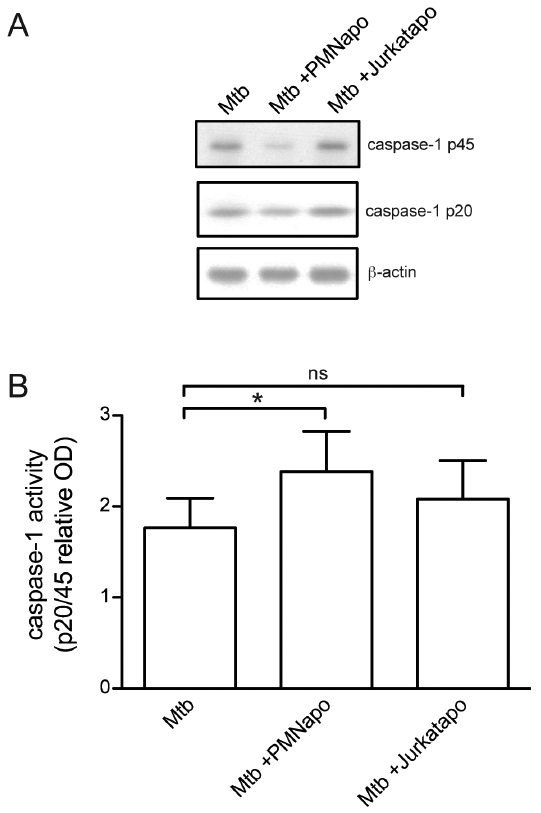
Figure 6. Apoptotic neutrophils augment caspase-1 activation in Mtb-stimulated hMDMs. hMDMs were stimulated with c -irr Mtb for one hour with or without subsequent stimulation with PMNapo or Jurkatapo at a ratio of 2:1 for one hour where after non-ingested prey were removed and the hMDMs were cultured for 3 h. hMDMs were extensively washed and lysed in Laemmli sample buffer. (A) Represen- tative SDS-PAGE immunoblots of hMDM cell lysates probed with anti- caspase-1 antibodies, detecting both unprocessed inactive caspase-1 (p45) and cleaved activated caspase-1 (p20). Membranes were then stripped and re-probed for b -actin as a control for equal loading. (B) Caspase-1 activity shown as the ratio between caspase-1 p20/caspase-1 p45 and data expressed as mean + SEM (n=4-5). Differences between groups were calculated using paired sample Student t-test, and significant differences are shown as * (p , 0.05); ns, not